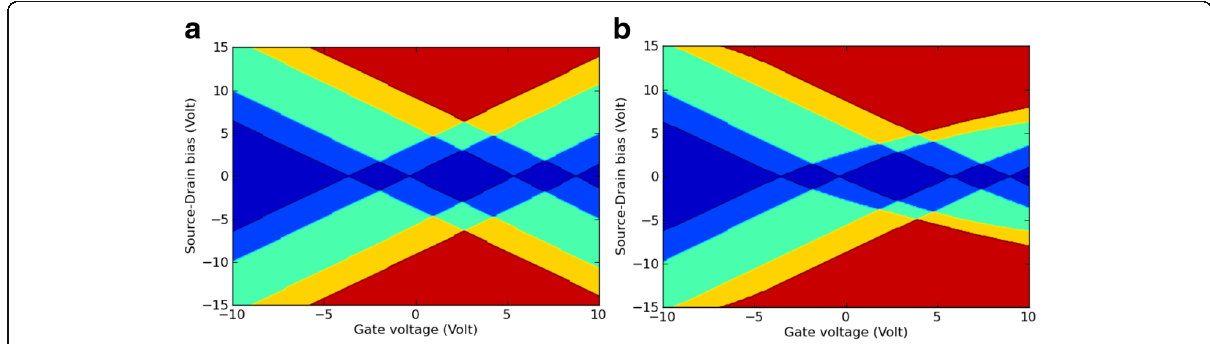
Fig. 7 The full self-consistently calculated charge stability diagrams for indigo ( a ) and Tyrian purple ( b ) SETs. These diagrams were calculated for the SET environment. The colors show the number of charge states in the bias window for a given V G . The color map is blue (0), light blue (1), green (2), orange (3), and red (4)